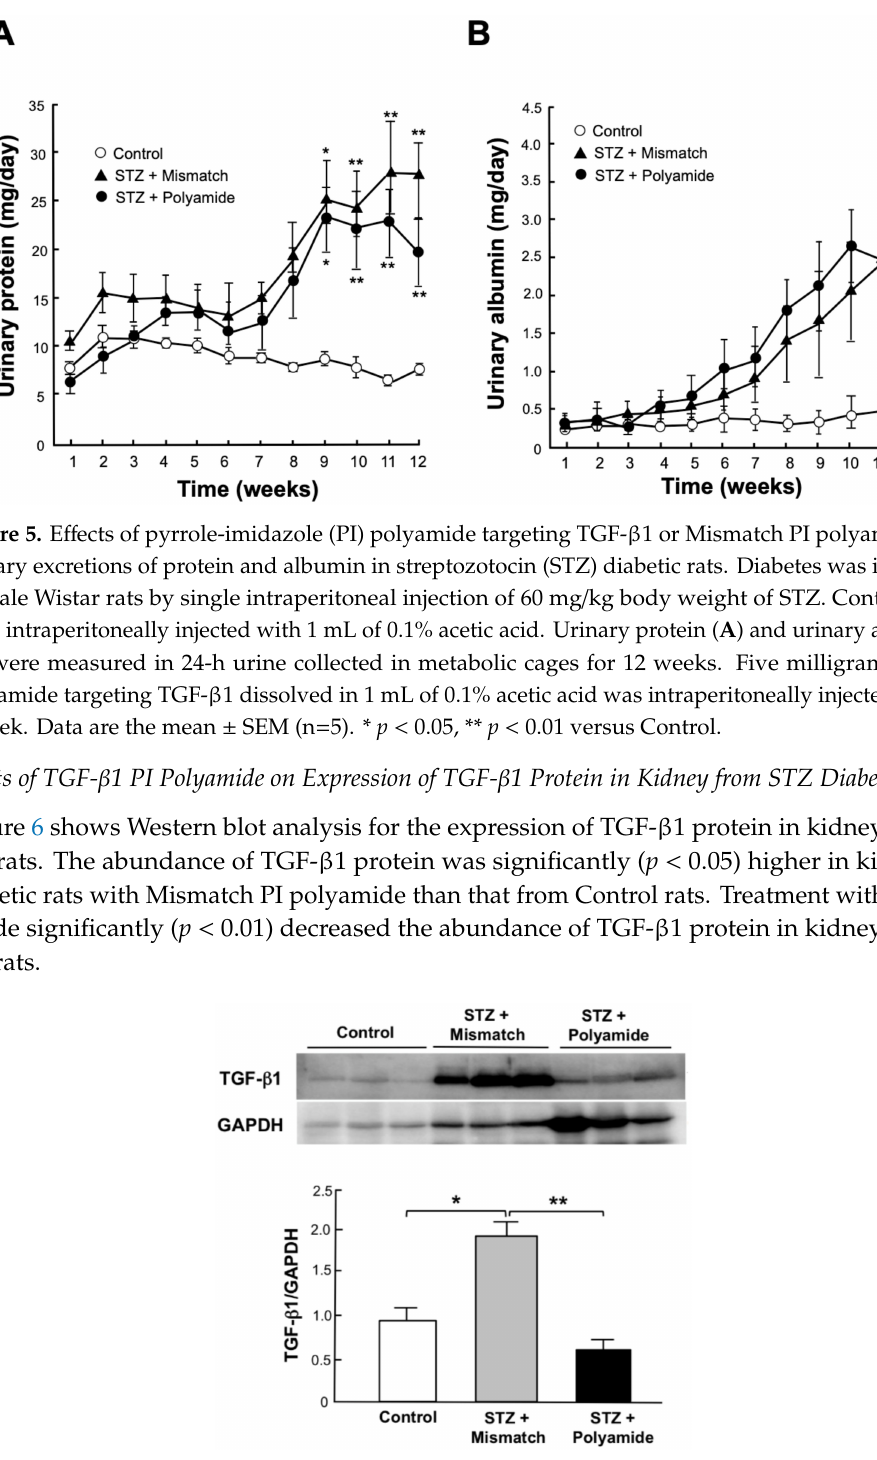
Figure 6. E ff ects of pyrrole-imidazole (PI) polyamide targeting TGF- β 1 on the expression of TGF- β 1 protein in kidney from streptozotocin (STZ) diabetic rats. Diabetes was induced in male Wistar rats by single intraperitoneal injection of 60 mg / kg body weight of STZ. Control rats were intraperitoneally injected with 1 mL of 0.1% acetic acid. Five milligrams of PI polyamide targeting TGF- β 1 or Mismatch polyamide dissolved in 1 mL of 0.1% acetic acid was intraperitoneally injected twice a week for 3 months, and then the rats were sacrificed to remove their kidneys. Expression of TGF- β 1 proteins was assessed by Western blot analysis. Data are the mean ± SEM ( n = 3). * p < 0.05, ** p < 0.01 between indicated